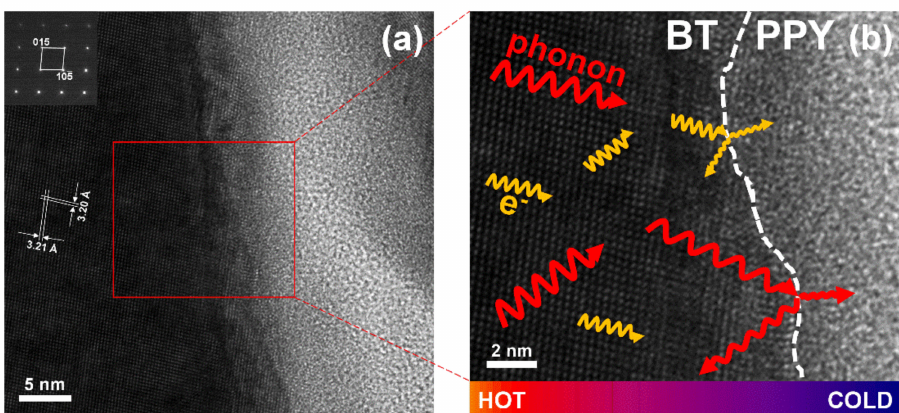
(cid:2) (cid:3) 551 direction (inlet) to